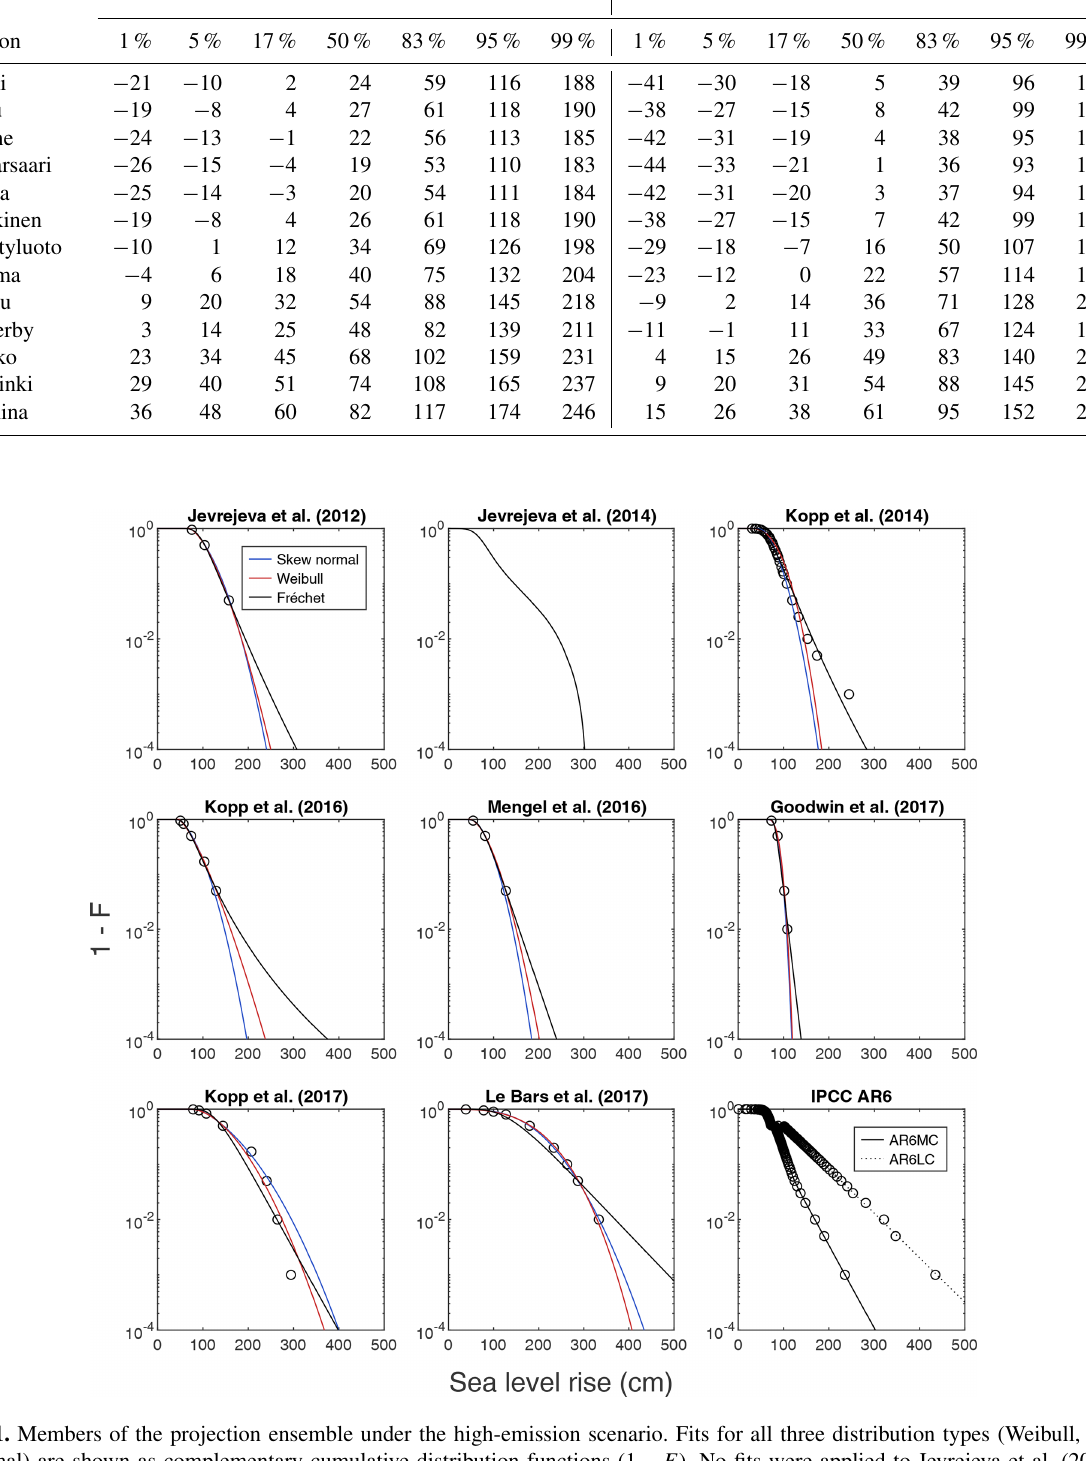
Table A4. Projected mean sea level (centimetres) at the Finnish tide gauges in 2100 under the high-emission scenario (RCP8.5/SSP5-8.5). High scenario 2100 (N2000) 2100 relative to 1995–2014 (8.5)